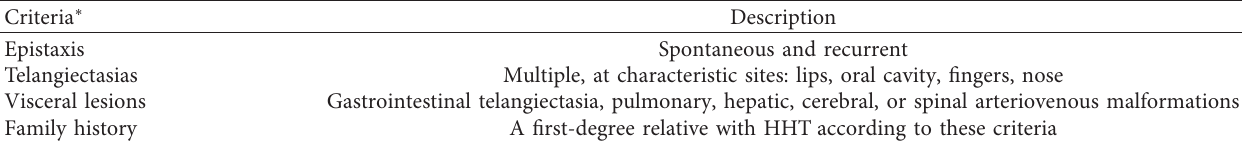
Table 1: Curaçao Criteria for clinical diagnosis of HHT.